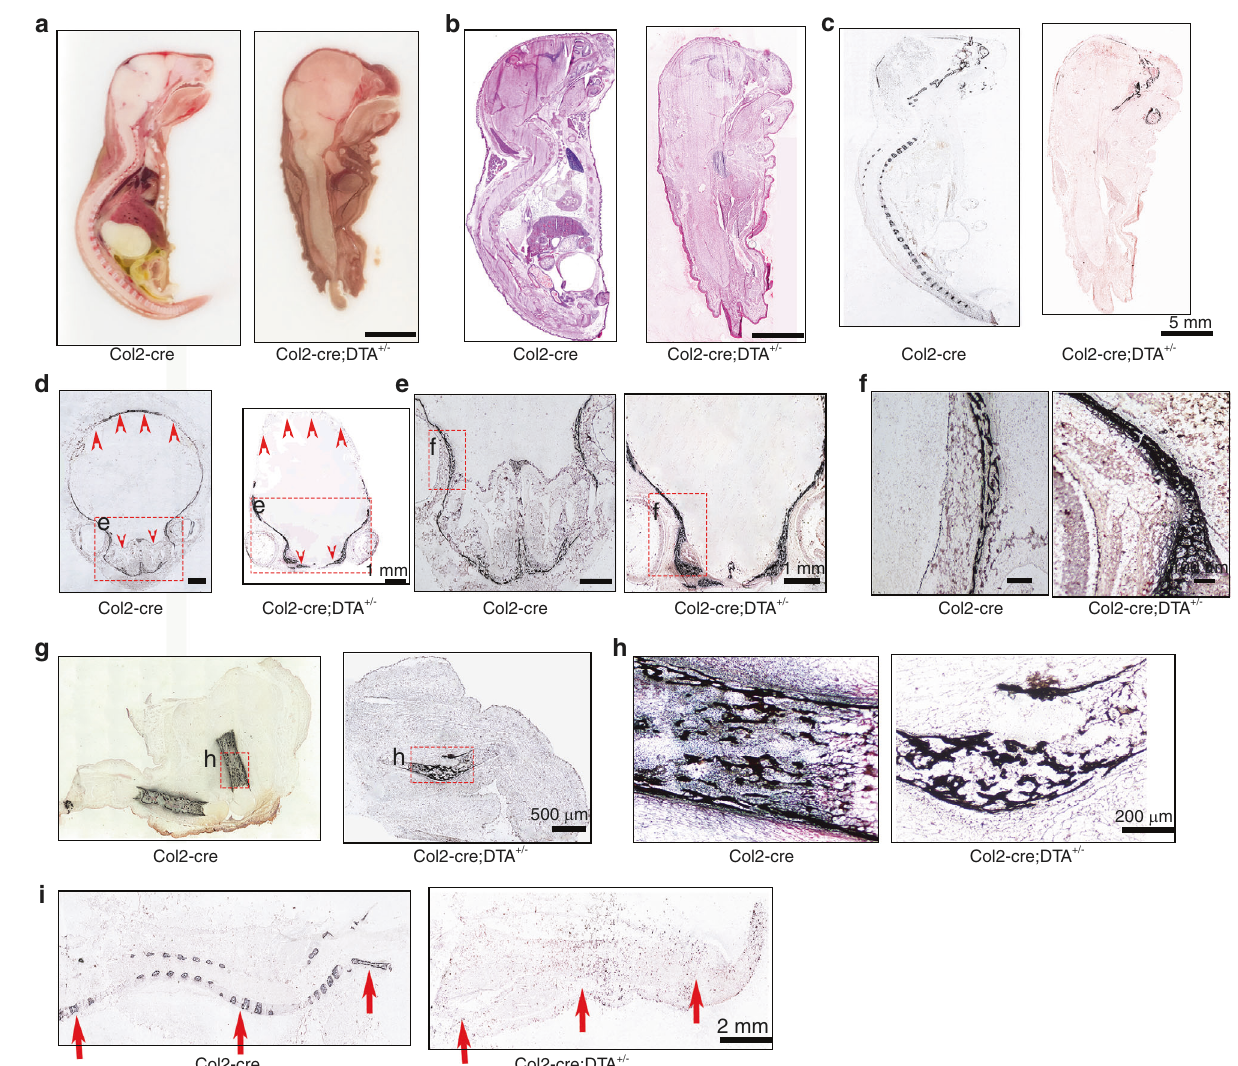
Fig. 3 Ablation of Col2 + cells results in absence of the spine and disruption of endochondral skeletal development. a Total view of middle sagittal sections of Col2-cre and Col2-cre;DTA + / − mice at P0. b H&E staining of the middle sagittal sections of Col2-cre and Col2-cre;DTA + / − mice at P0. c Von Kossa staining of the middle sagittal sections of Col2-cre and Col2-cre;DTA + / − mice at P0. d Von Kossa staining of the skull with transection. Yellow arrow, severe bone loss in the back of the skull of Col2-cre;DTA + / − mice. Yellow star, nasal cavity area in Col2-cre and Col2-cre;DTA + / − mice. e Von Kossa staining of craniofacial bone showing loss of the nasal cavity in mutant mice. f Higher magni fi cation of Von Kossa staining showing similar sponge-like bone structures in both wild-type and mutant mice. g Von Kossa staining of bone in the hindlimbs of wild-type and mutant mice. h Higher magni fi cation of Von Kossa staining of the hindlimbs of wild-type and mutant mice. Note that a small piece of well-calci fi ed sponge-like bone structure can be detected in mice with ablation of Col2 + cells. i Von Kossa staining of the middle sagittal section of the spine of wild-type and mutant mice. Red arrow, severe vertebral bone loss in Col2-cre;DTA + / − mice. n = 6 mice per condition; three independent (Fig. 4h). Quantitative analysis demonstrated that the lengths of the femur and tibia bones of the mutant group were signi fi cantly shortened to 0.55 cm and 0.78 cm, respectively, compared with the lengths of 1.22 cm and 1.4 cm found in the WT mice (Fig. 4i). Moreover, the postnatal ablation of Col2 + cells also impaired skull and long bone and cartilage development (Fig. 4j, k).